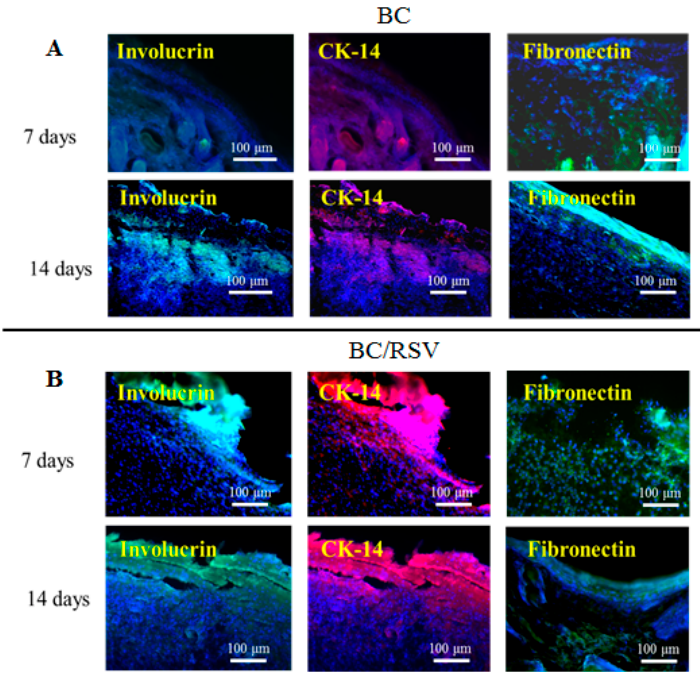
Figure 10. Keratinocyte differentiation on BC- and BC/RSV-scaffold implants in skin defects after 7 and 14 d. Implant areas were detected by immunofluorescence staining for involucrin (green) and CK-14 (red) in wound tissue for different groups at 7 d after implantation. The BC/RSV group showed relatively higher levels of involucrin- and CK-14-positive keratinocytes. The re-epithelialization marker fibronectin (green) was present in the BC-scaffold group at 14 d after implantation. Nuclei were counterstained with Hoechst 33342 (blue). Scale bar = 100 μ m.